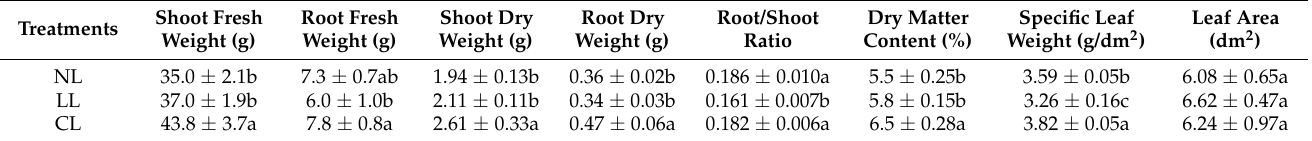
Note: The data in the table are the means ± standard deviations. Different letters indicate significant differences between different treatments at p < 0.05 according to the Tukey